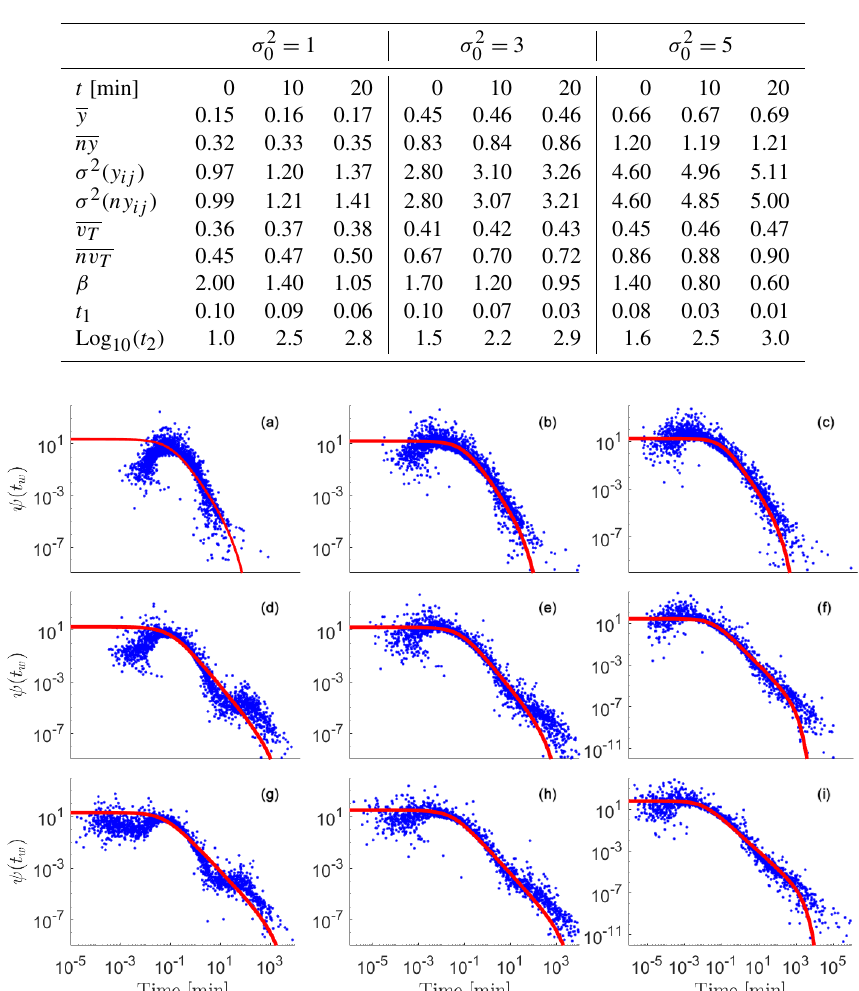
Table 1. Values of mean and variance of unweighted and weighted log-conductivity distributions and estimated parameters of the effected TPL model obtained through calibration of Eq. (6) against the computed distributions of particle waiting times in the domain cells. Results are listed for the three values of the initial log-conductivity variance ( σ 2 ) and are obtained from non-reactive transport simulations performed 0 across conductivity fields resulting from reactive transport simulations at selected times.